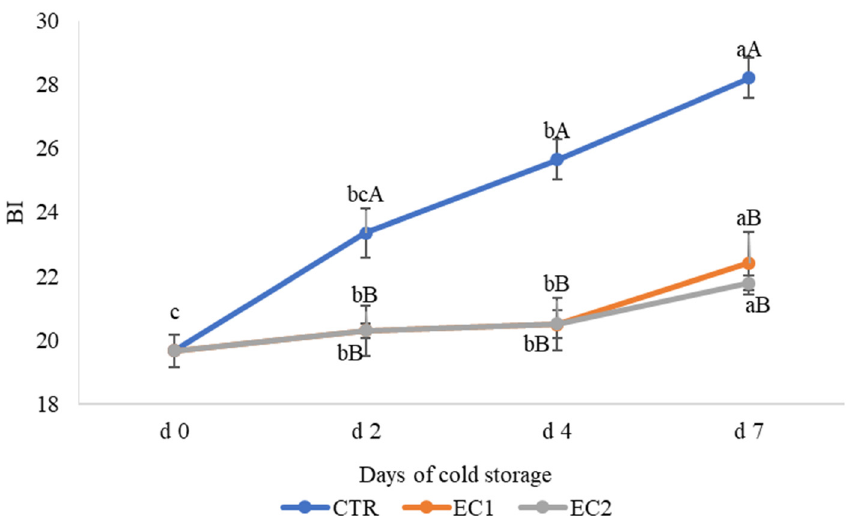
Figure 3. Development of browning index (BI) of treated (EC1 and EC2) and untreated (CTR) pear slices. Data correspond to the means ± standard deviation of three replicates. Means with different letters are significantly different at p ≤ 0.05 using Tukey’s-HSD test. Different lowercase letters denote significant differences ( p < 0.05) between different sampling times for the same treatment. Different capital letters denote significant differences ( p < 0.05) between different treatments for the same sampling time.